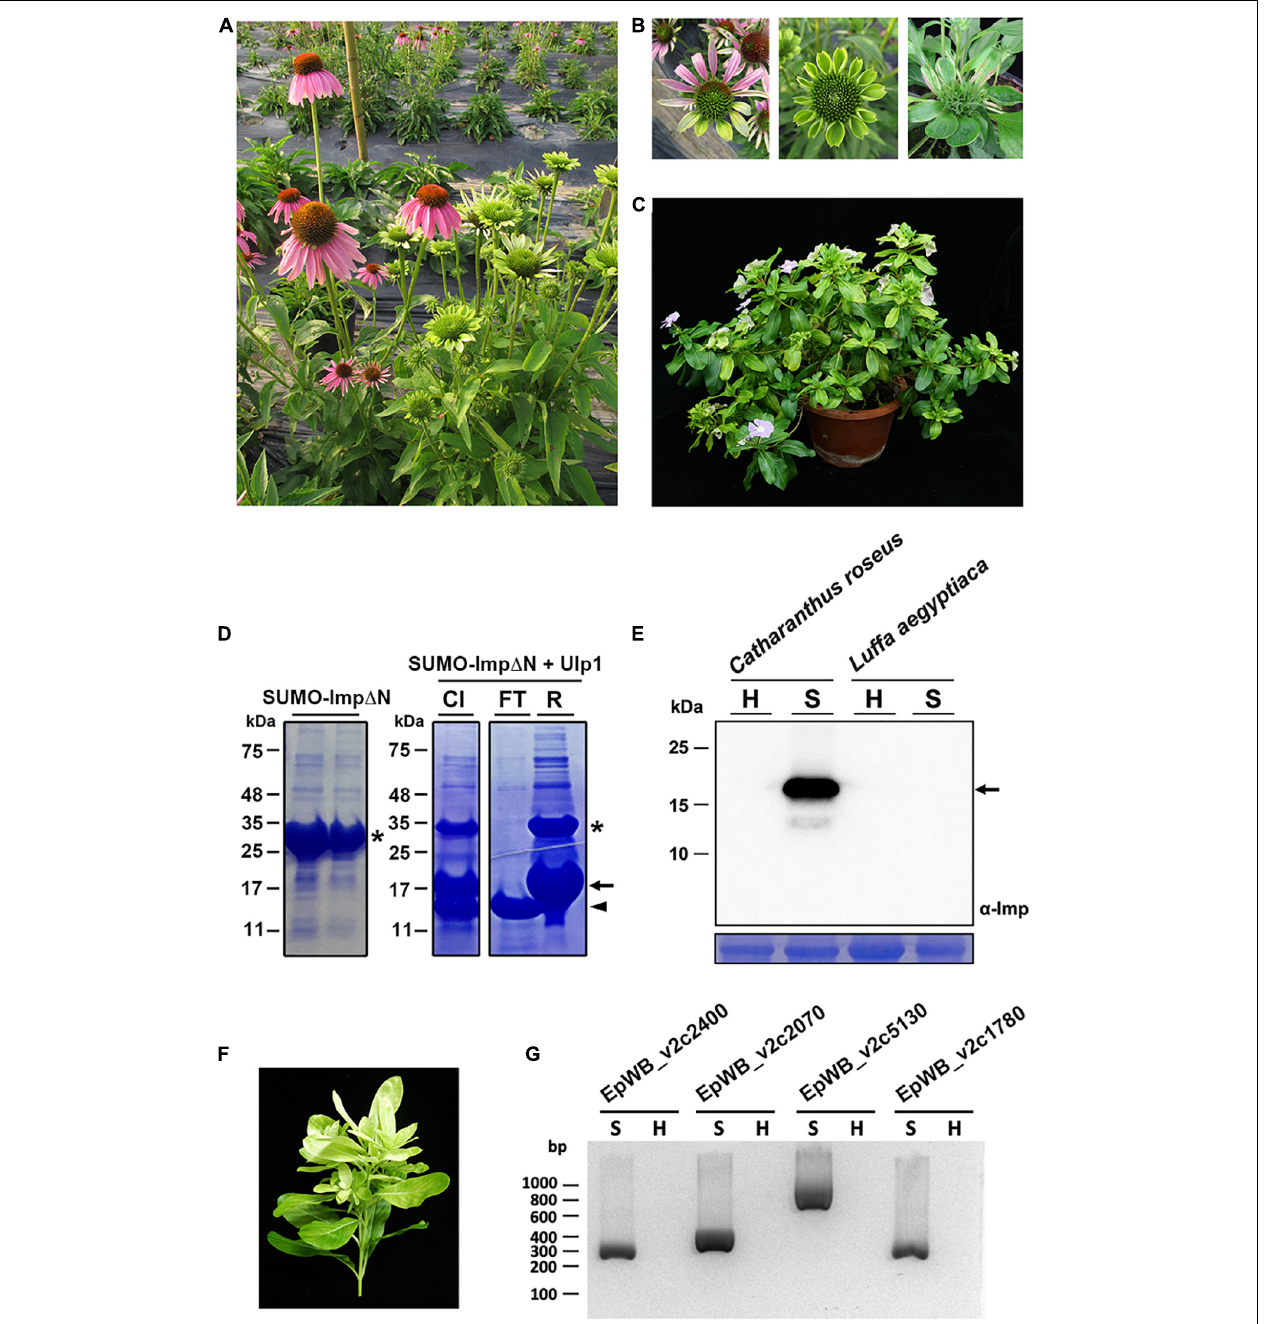
FIGURE 1 | Immunoprecipitation-based enrichment of ‘ Ca . P. aurantifolia’ NCHU2014. (A) Phenotypic comparisons between healthy (left) and ‘ Ca . P. aurantifolia’ NCHU2014-infected (right) purple coneflower ( Echinacea purpurea ). The diseased plants exhibited phyllody and witches’ broom symptoms. (B) Enlarged images of the abnormal flowers carrying phyllody, virescence, and bud proliferation symptoms in ‘ Ca . P. aurantifolia’ NCHU2014-infected purple coneflower. (C) Symptomatic periwinkle ( Catharanthus roseus ) associated with ‘ Ca . P. aurantifolia’ NCHU2014 transmitted by dodder. (D) The His-SUMO tagged Imp (cid:49) N was expressed in E. coli and purified by Ni 2 + -NTA resin (left panel). After cleavage of the His-SUMO tag by Ulp1 (CI), the reaction mixture was applied on the Ni 2 + -NTA column. Arrowhead indicates the purified Imp (cid:49) N in flowthrough (FT); asterisk and arrow indicate the uncleaved His-SUMO-Imp (cid:49) N and His-SUMO, respectively, in the resin (R). (E) Total cell extracts prepared from healthy (H) and symptomatic (S) leaves were examined by Western blotting using specific antibody against Imp of ‘ Ca . P. aurantifolia’ NCHU2014. The specific signal of Imp was only detected in symptomatic C. roseus infected with ‘ Ca . P. aurantifolia’ NCHU2014, but not symptomatic loofah ( Luffa aegyptiaca ) infected with ‘ Ca . P. luffae’ NCHU2019 (upper panel). As a loading control, the large subunit of Rubisco was visualized with Coomassie Brilliant Blue staining (lower panel). Arrow indicates the 19 kDa Imp. (F) The ‘ Ca . P. aurantifolia’ NCHU2014-infected periwinkle used for immunoprecipitation. (G) PCR examination of DNA extracted from the immunoprecipitated fraction containing ‘ Ca . P. aurantifolia’ NCHU2014.